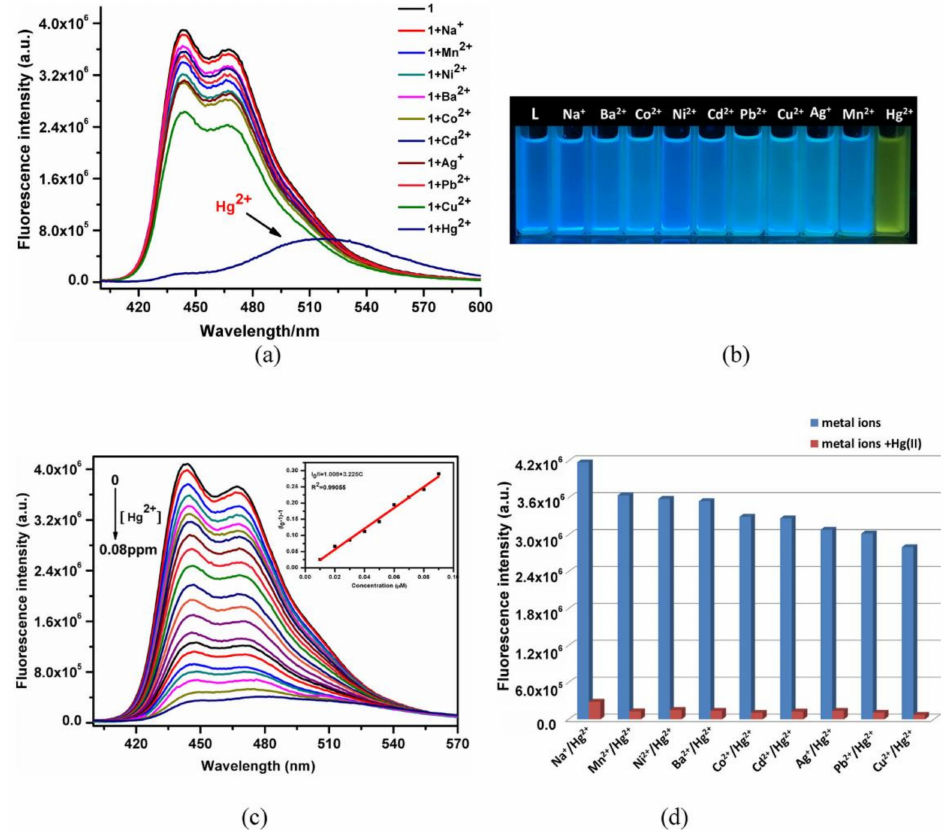
Figure 5. ( a ) Emission spectra of {[Zn2(1,4-bpyvna)(1,3,5-BTC)(OH)] · H2O} n in DMF in the absence/presence of Mn+ ions. ( b ) The colours of the suspensions of {[Zn2(1,4-bpyvna)(1,3,5-BTC)(OH)] · H2O} n with different metal ions under UV light. ( c ) Emission spectra of {[Zn2(1,4-bpyvna)(1,3,5-BTC)(OH)] · H2O} n in the presence of increasing Hg 2+ concentrations (0–0.08 ppm) in DMF. Inset: linear relation between the quenching efficiency and the concentration of Hg 2+ in the range of 0–0.018 ppm. ( d ) Fluorescence intensities of {[Zn2(1,4-bpyvna)(1,3,5-BTC)(OH)] · H2O} n immersed in the DMF solution of metal ion (blue colour) or mixed Hg2+ and metal ions (red colour) under an excitation of 389 nm (Reproduced with the permission from Ref